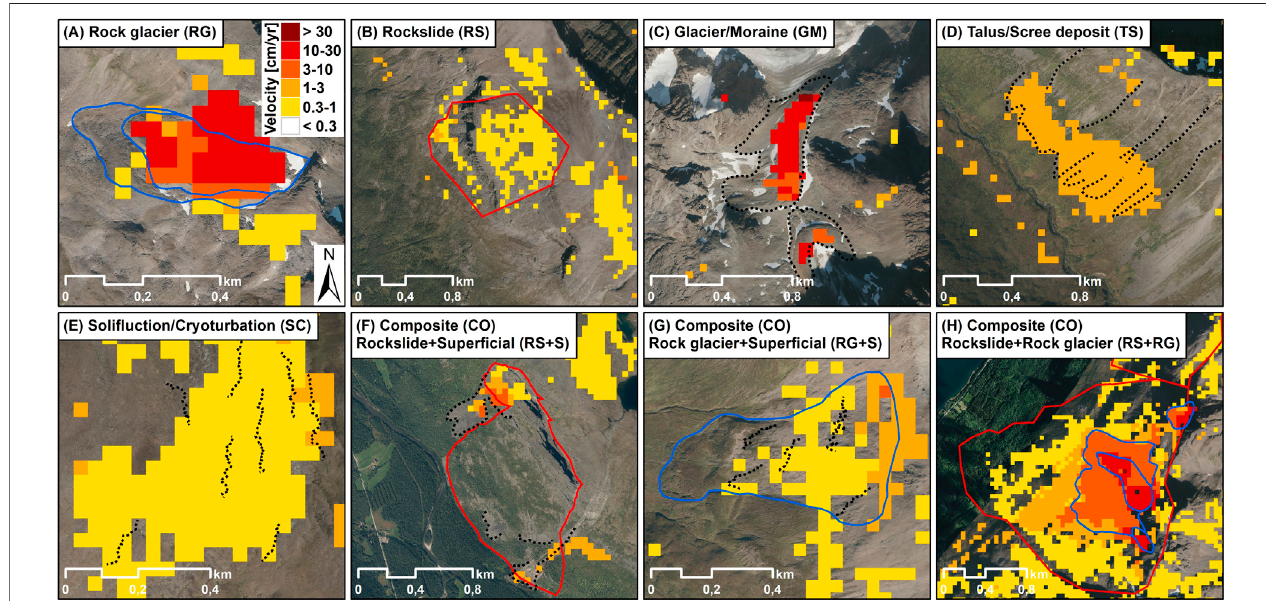
FIGURE 6 | Classi fi ed InSAR results for each landform category (based on Figure 3 ). Locations (A – H) are shown in Figures 4 , 5 . The lines highlight indicative morphologic delineations (blue: rock glaciers; red: rockslides, dashed black: others morphologic features, in (C) : debris-covered glacier and ice-cored moraine; in (D) : gullies and talus cones; in (E) and (G) : soli fl uction lobes). Note that the classes “ Decorrelated ” , “ Layover/Shadow ” , and “ N-S slopes ” are not displayed for the sake of visualization. Norge i bilder orthophotos from NMA (2020b).